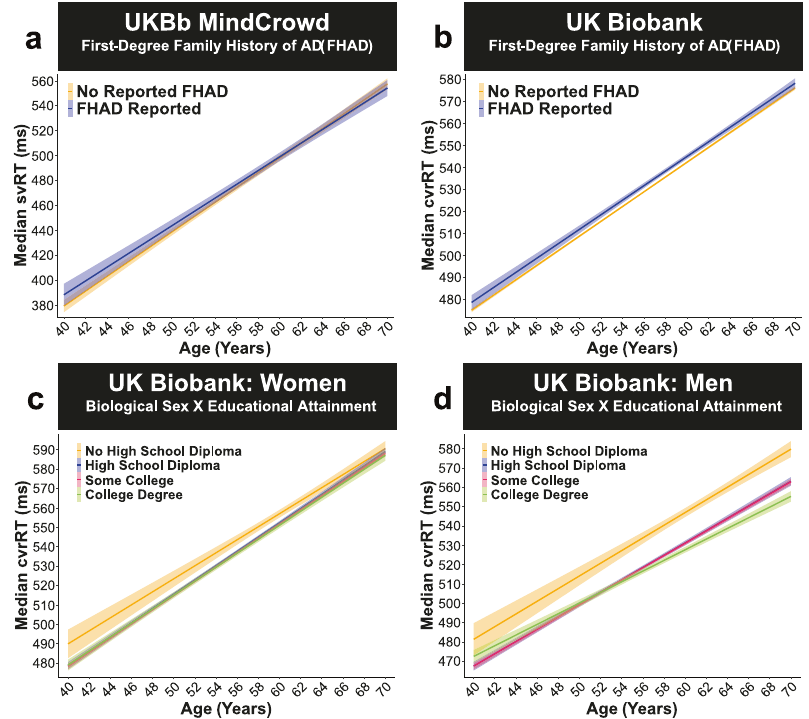
Fig. 8 UK Biobank: FHAD biological and sex × educational attainment. UKBb MindCrowd and UK Biobank analysis (ages 40 – 70) of visual reaction time (RT). a – b A fi rst-degree family history of Alzheimer ’ s disease (FHAD) was related to longer complex visual recognition reaction time (cvrRT)s in the UK Biobank, but not simple visual reaction time (svRT) in UKBb MindCrowd. a UKBb MindCrowd linear model fi ts (line fi ll ±95% CI) of median svRT from young to old Age with lines split by reported FHAD. An association between FHAD and svRT was not found in the UKBb MindCrowd cohort ( β FHAD = − 0.07, p FHAD = 0.97, FHAD Reported n = 13,748, No FHAD Reported n = 26,047). b UK Biobank linear model fi ts (line fi ll ±95% CI) of median cvrRT from young to old Age with lines split by reported FHAD. Compared to those reporting No FHAD, FHAD was related to worse cvrRT performance in the UK Biobank ( β FHAD = 2.36, p FHAD = 3.35E − 05, FHAD Reported n = 19,741, No FHAD Reported n = 138,504). c – d In the UK Biobank, Biological Sex modi fi ed the association of Educational Attainment on cvrRT (Biological Sex × Educational Attainment interaction). Linear model fi ts (line fi ll ±95% CI) of the median cvrRT by Age with lines split by Educational Attainment in c women and ( d ) men. Compared to c women having “ No High School Diploma ” ( n = 6056), ( d ) men with a “ High School Diploma ” ( β Sex*HSDiploma = − 11.24, p Sex*HSDiploma = 3.30E − 12, n = 18,505), “ Some College ” ( β sex*College = − 10.54, p sex*College = 8.71E − 12, n = 34,230) or a “ College Degree ” ( β